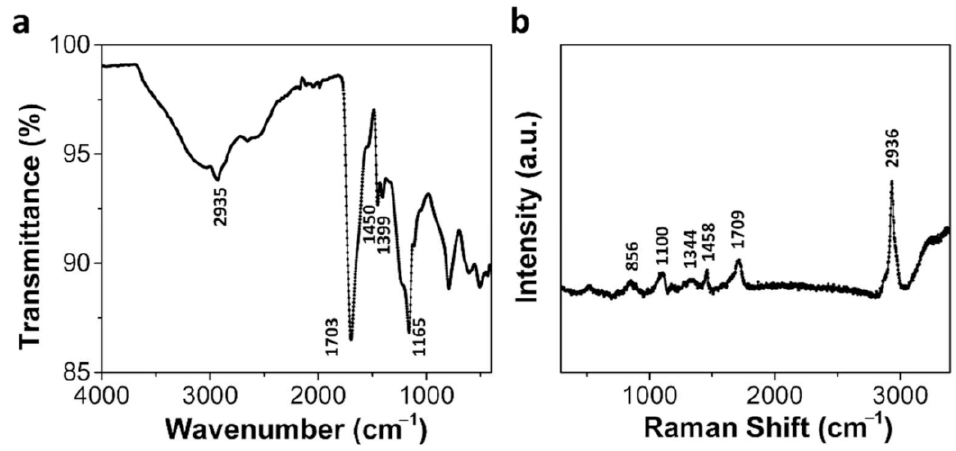
Figure 7. IR ( a ) and Raman spectrum ( b ) of the MLGP/PAA